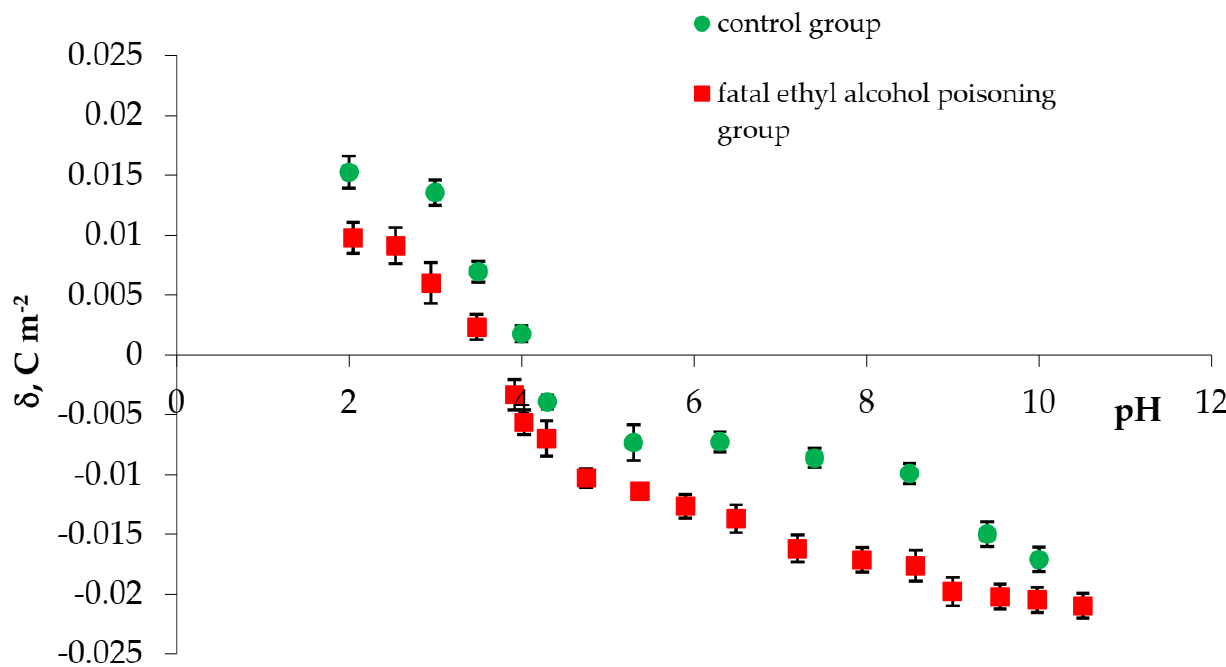
Figure 1. The experimental surface charge density of erythrocytes vs. pH of the electrolyte solution • —control, (cid:4) —fatal ethyl alcohol poisoning.